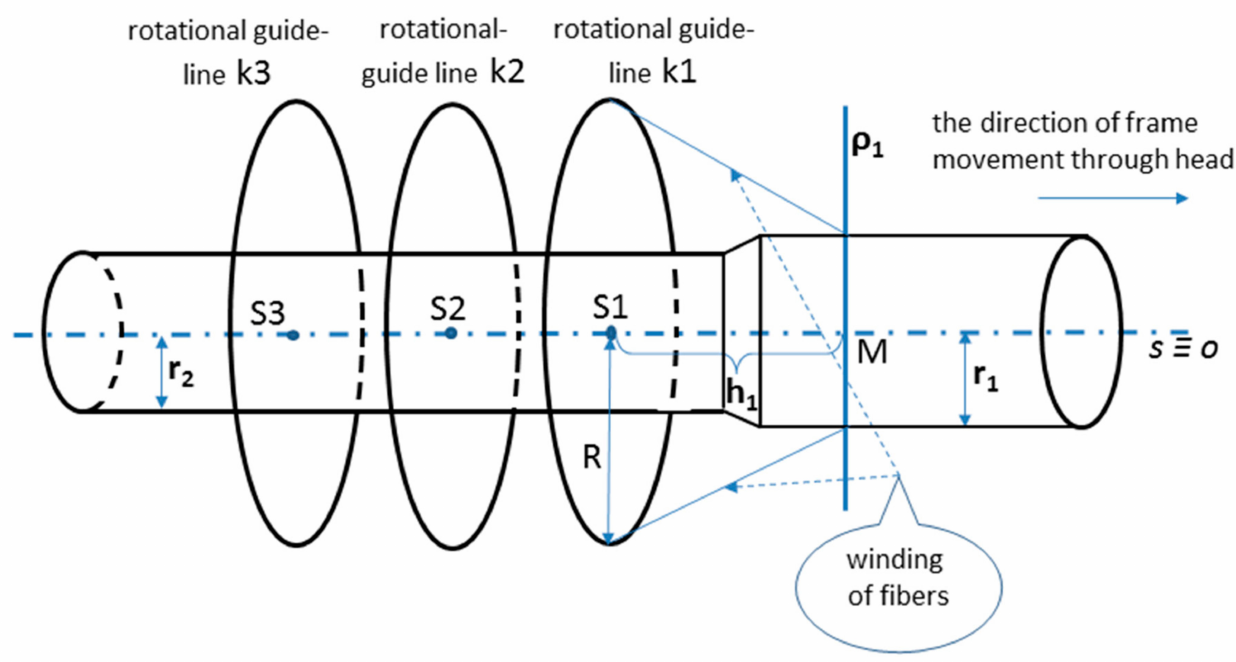
Figure 4. Diagram of the passage frame through the fiber-processing head with three guide-lines. For the first guide-line k1, the plane of fibers winding onto the frame is marked ρ 1 , which is perpendicular to the axis s of the winding head (and in this case also to the axis o of the